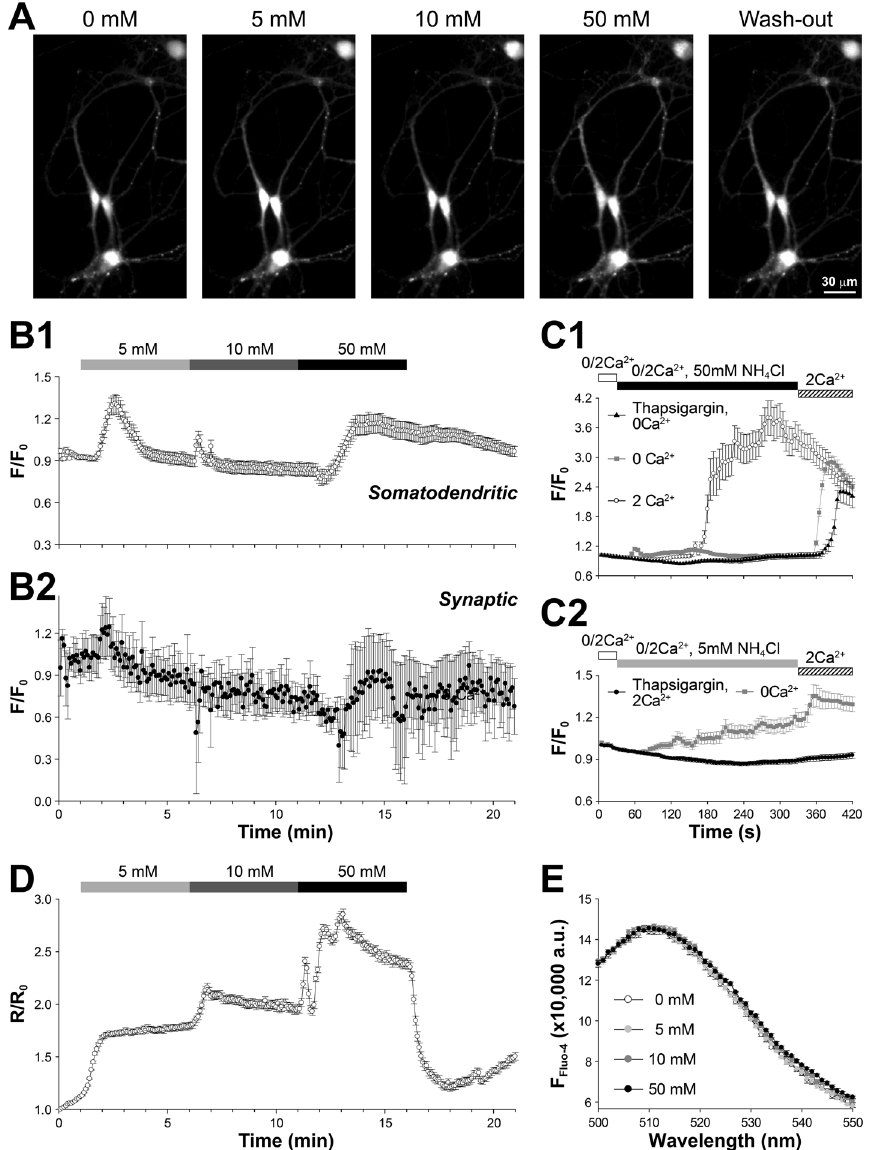
Figure 2. Effects of NH 4 Cl on intracellular calcium ([Ca 2 + ] i ). ( A ) Sample images on neurons preloaded with Fluo-4-AM and sequentially exposed to different concentrations of NH 4 Cl. ( B ) Fluo-4 fluorescence change (normalized to the pretreatment baseline) in response to different concentrations of NH 4 Cl as indicated (n = 300 randomly selected synaptic boutons from 6 independent trials). ( B1 ) In somatodendritic regions 5 mM NH 4 Cl caused strong (~34.2%) but transient increase of Fluo-4 fluorescence. The response to subsequent 10 mM NH 4 Cl application was smaller, whereas 50 mM NH 4 Cl lead to a [Ca 2 + ] i increase comparable to that of 5 mM NH 4 Cl but lasted even after the 5-min wash-off. ( B2 ) [Ca 2 + ] i change in SypHTm-defined synaptic areas resembled that of somatodendritic areas. In both cases, a gradual decrease of Fluo-4 fluorescence occurred likely due to photobleaching and dye loss. ( C ) NH 4 Cl-induced [Ca 2 + ] i changes during 0 Ca 2 + or after thapsigargin pretreatment. ( C1 ) The prolonged [Ca 2 + ] i increase (white circles) caused by 50 mM NH 4 Cl was diminished with 0 Ca 2 + (gray squares), and the resupply of 2 mM extracellular Ca 2 + led to a large [Ca 2 + ] i increase with or without thapsigargin pretreatment (black triangles). For each group, 10 ROIs/FOV were randomly selected and 4 FOVs were analyzed. ( C2 ) The transient [Ca 2 + ] i increase caused by 5 mM NH 4 Cl was significantly reduced with 0 Ca 2 + (gray squares), and the resupply of 2 mM extracellular Ca 2 + led to additional [Ca 2 + ] i increase. Thapsigargin pretreatment eliminated those two [Ca 2 + ] i increases (black circles). For each group, 10 ROIs/FOV were randomly selected and 4 FOVs were analyzed. ( D ) Cytosolic pH changes upon various concentrations of NH4Cl were measured by ratiometric imaging of BCECF fluorescence (R = F 480 /F 440 , i.e. excited at 440 and 480 nm, and fluorescence imaged with 510 ± 10 nm band-pass emission filter), which was further normalized to the initial R 0 before any treatments. The cytosolic pH changes are very different from [Ca 2 + ] i change reported by Fluo-4 ( B ). ( E ) Spectrofluorometry scan of F Fluo-4 emission with 480 nm excitation in the presence of different concentrations of NH 4 Cl as indicated. Four repeats for every